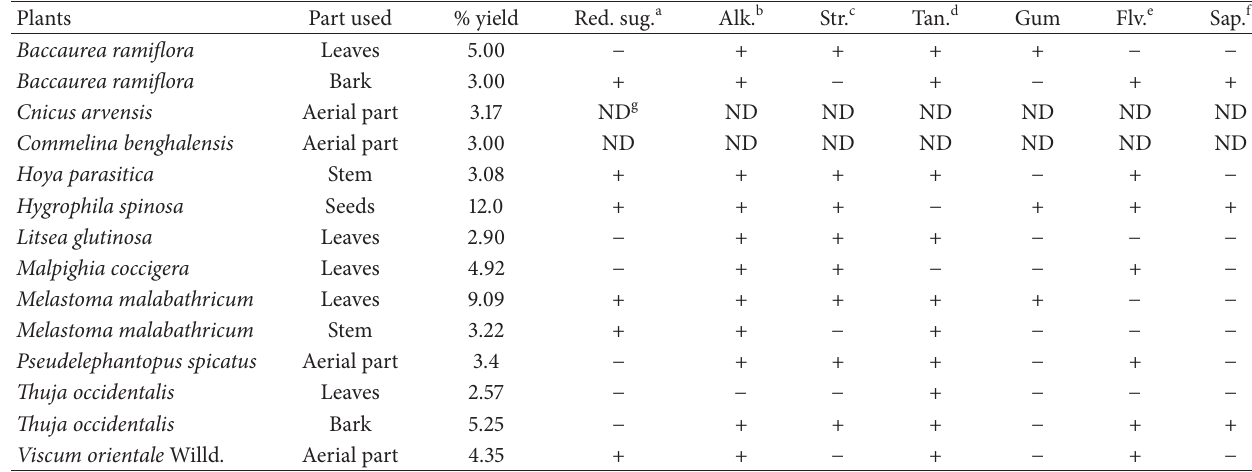
Table 3: Phytochemical evaluation of the fourteen extracts of eleven medicinal plants of Bangladesh.